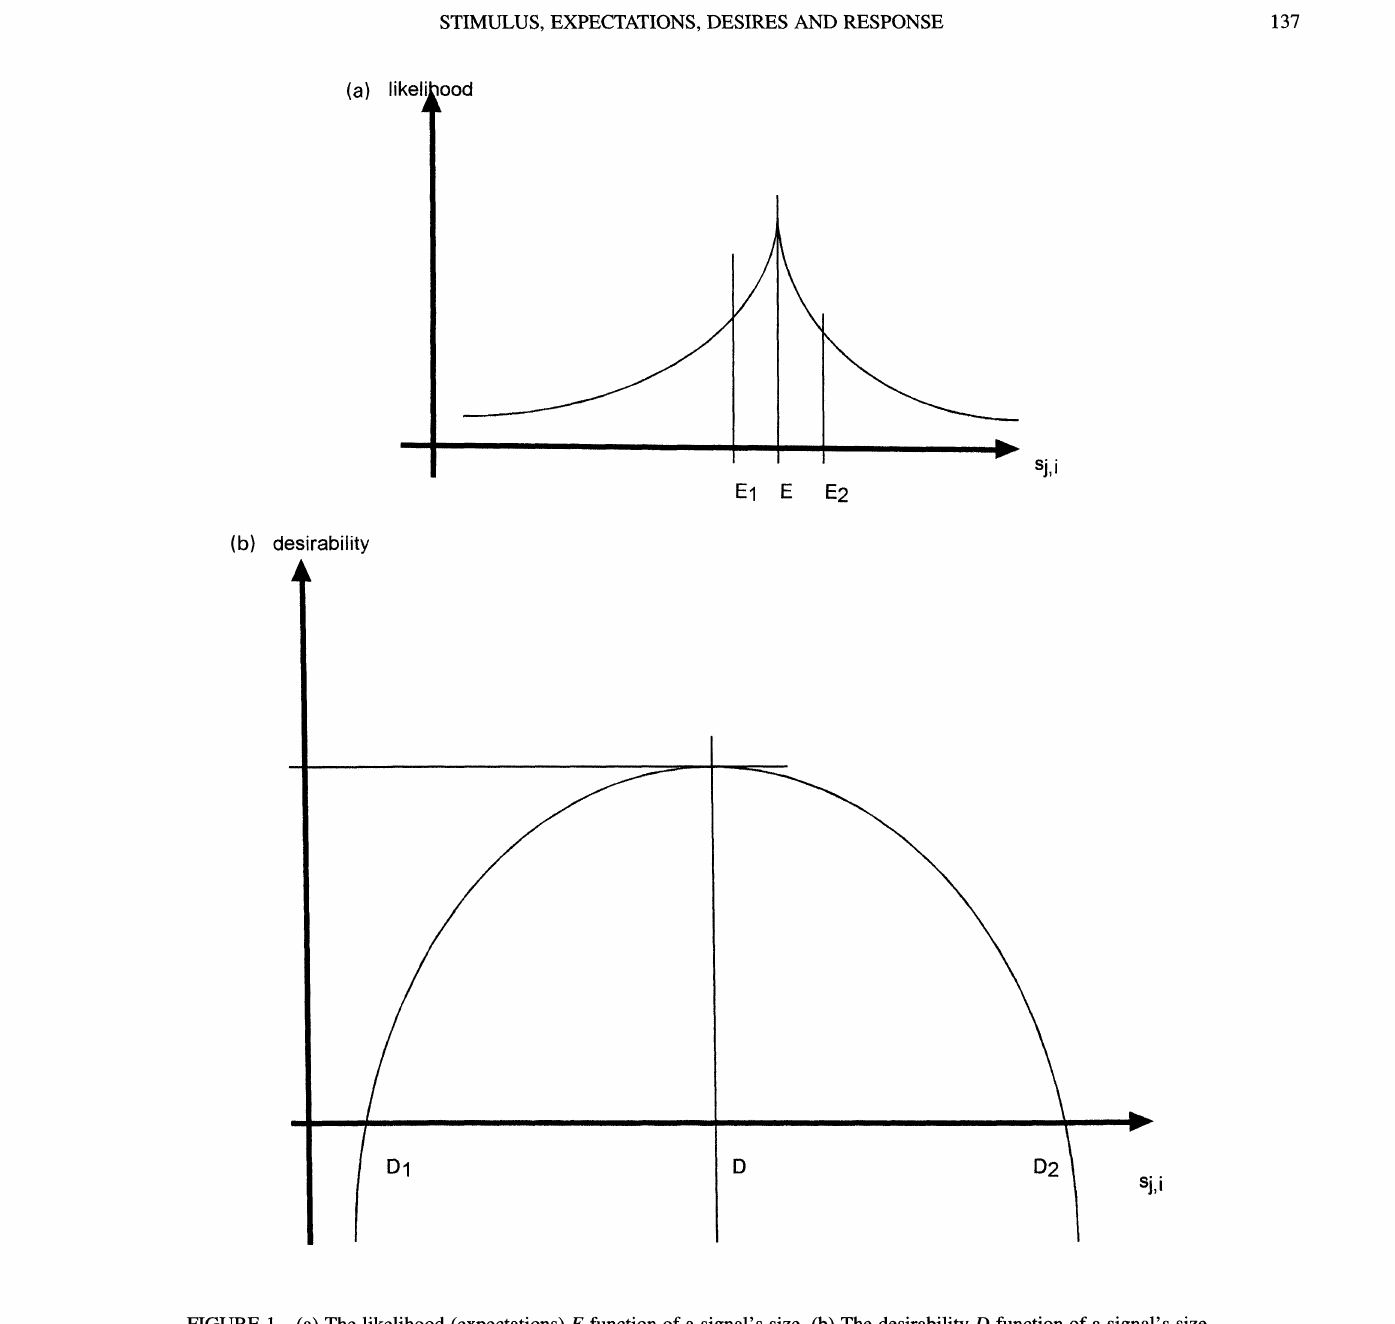
FIGURE (a) The likelihood (expectations) E-function of a signal’s size. (b) The desirability D-function of a signal’s